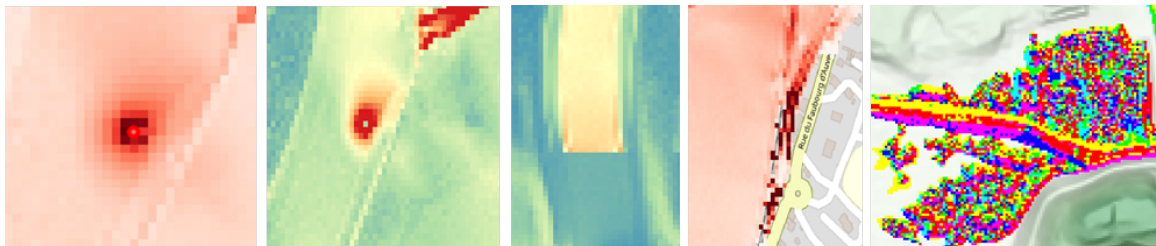
Figure 2. Examples of inconsistencies visually appearing in hydraulic simulated data. From left to right: local water level increase, sudden breaks in water levels or flow direction and velocities, apparently chaotic flow directions